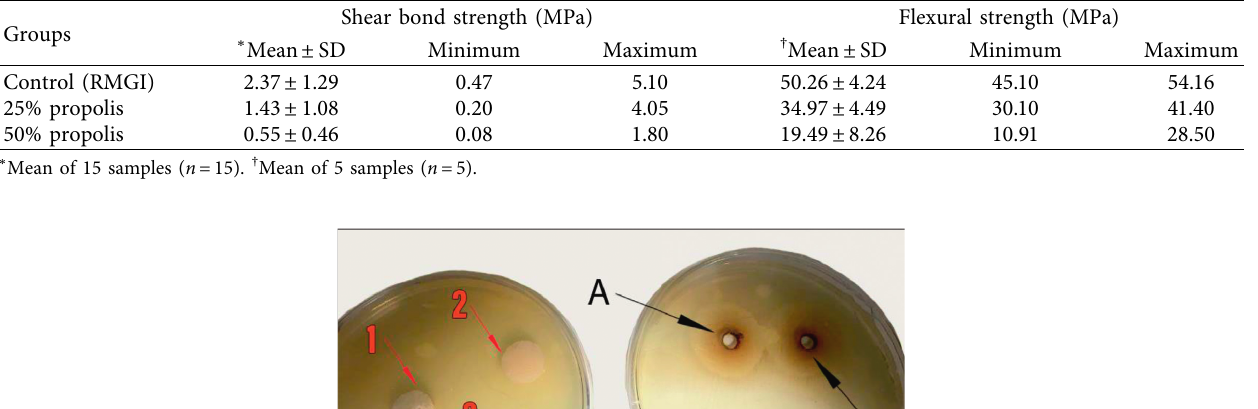
Table 1: Mean ± SD shear bond strength and flexural strength values.